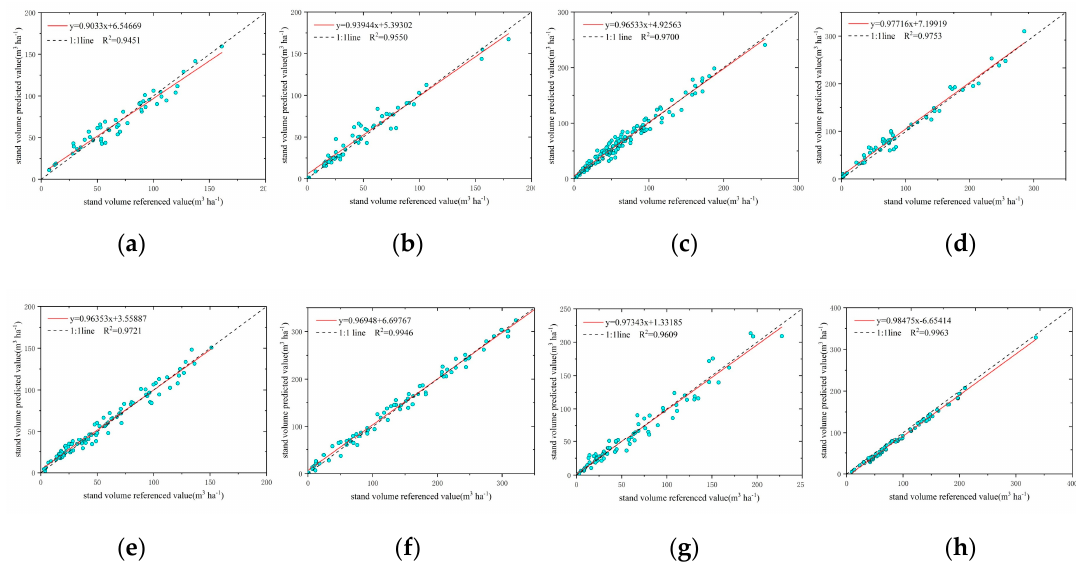
Figure 2. Referenced and predicted values of stand volume plotted, for Betula platyphylla Suk. ( a ), Cupressus funebris Endl. ( b ), Quercus spp. ( c ), Populus ( d ), Pinus massoniana Lamb. ( e ), Picea asperata Mast. ( f ), Larix gmelinii (Ruprecht) Kuzeneva ( g ), and Cunninghamia lanceolata (Lamb.) Hook. ( h ). 3.3. Results of Aboveground Biomass (AGB) and Aboveground Carbon (AGC) for Different Forest Types in China